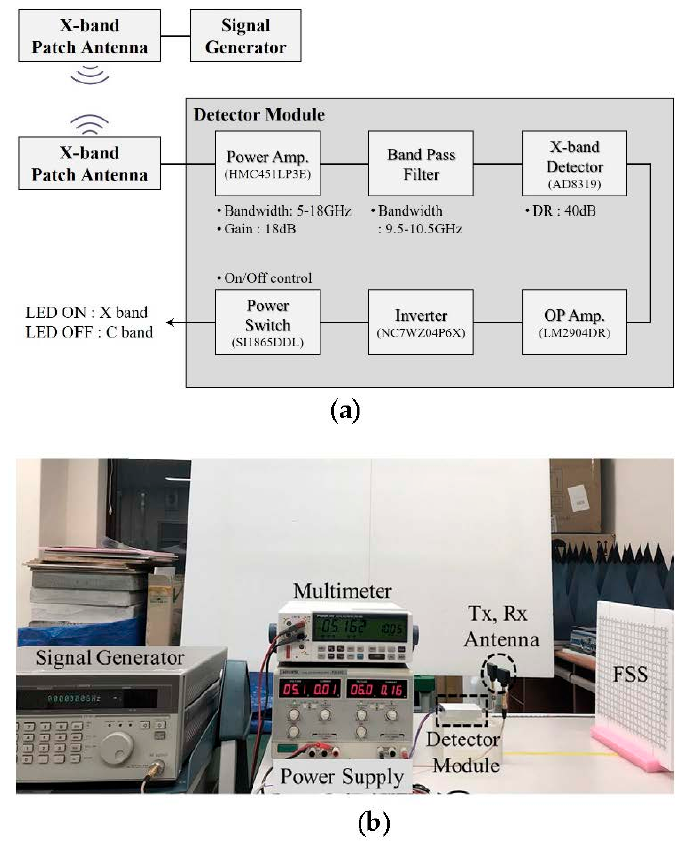
Figure 7. Detector measurement setup: ( a ) block diagram; ( b ) measurement setup.